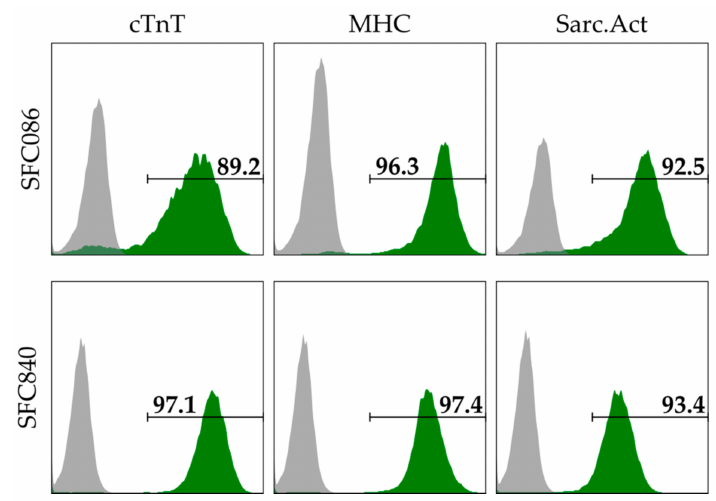
Figure 1. Flow cytometry-based assessment of cardiomyocyte (CM) content using immunofluorescent stains specific to cardiac troponin T (cTnT), pan-myosin heavy chain (MHC), and sarcomeric actinin (Sarc.Act). Depending on the marker, the CM content of the SFC086 cell line and the SFC840 cell line was ~89–96% and ~93–97% respectively. CM content was assessed at day 10–14 after induction of differentiation, i.e., when the cells were used for spheroid